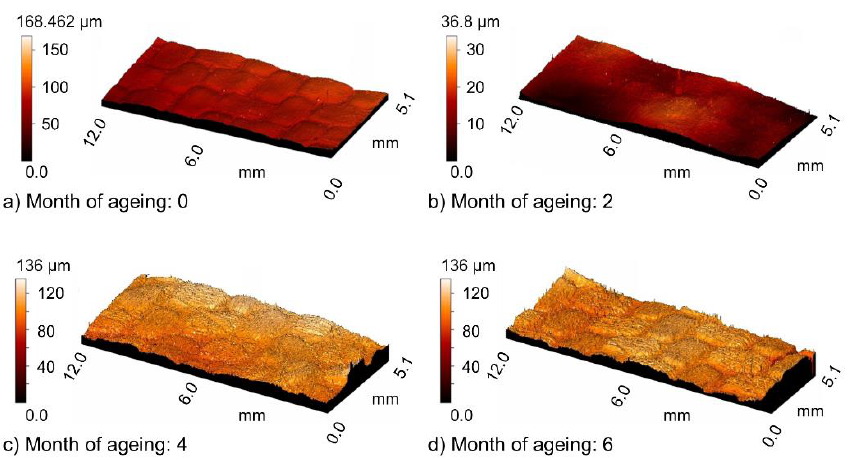
Figure 4. Texture of the examined surface prior to abrasive wear after ( a ) 0, ( b ) 2, ( c ) 4, and ( d ) 6 months of weathering.